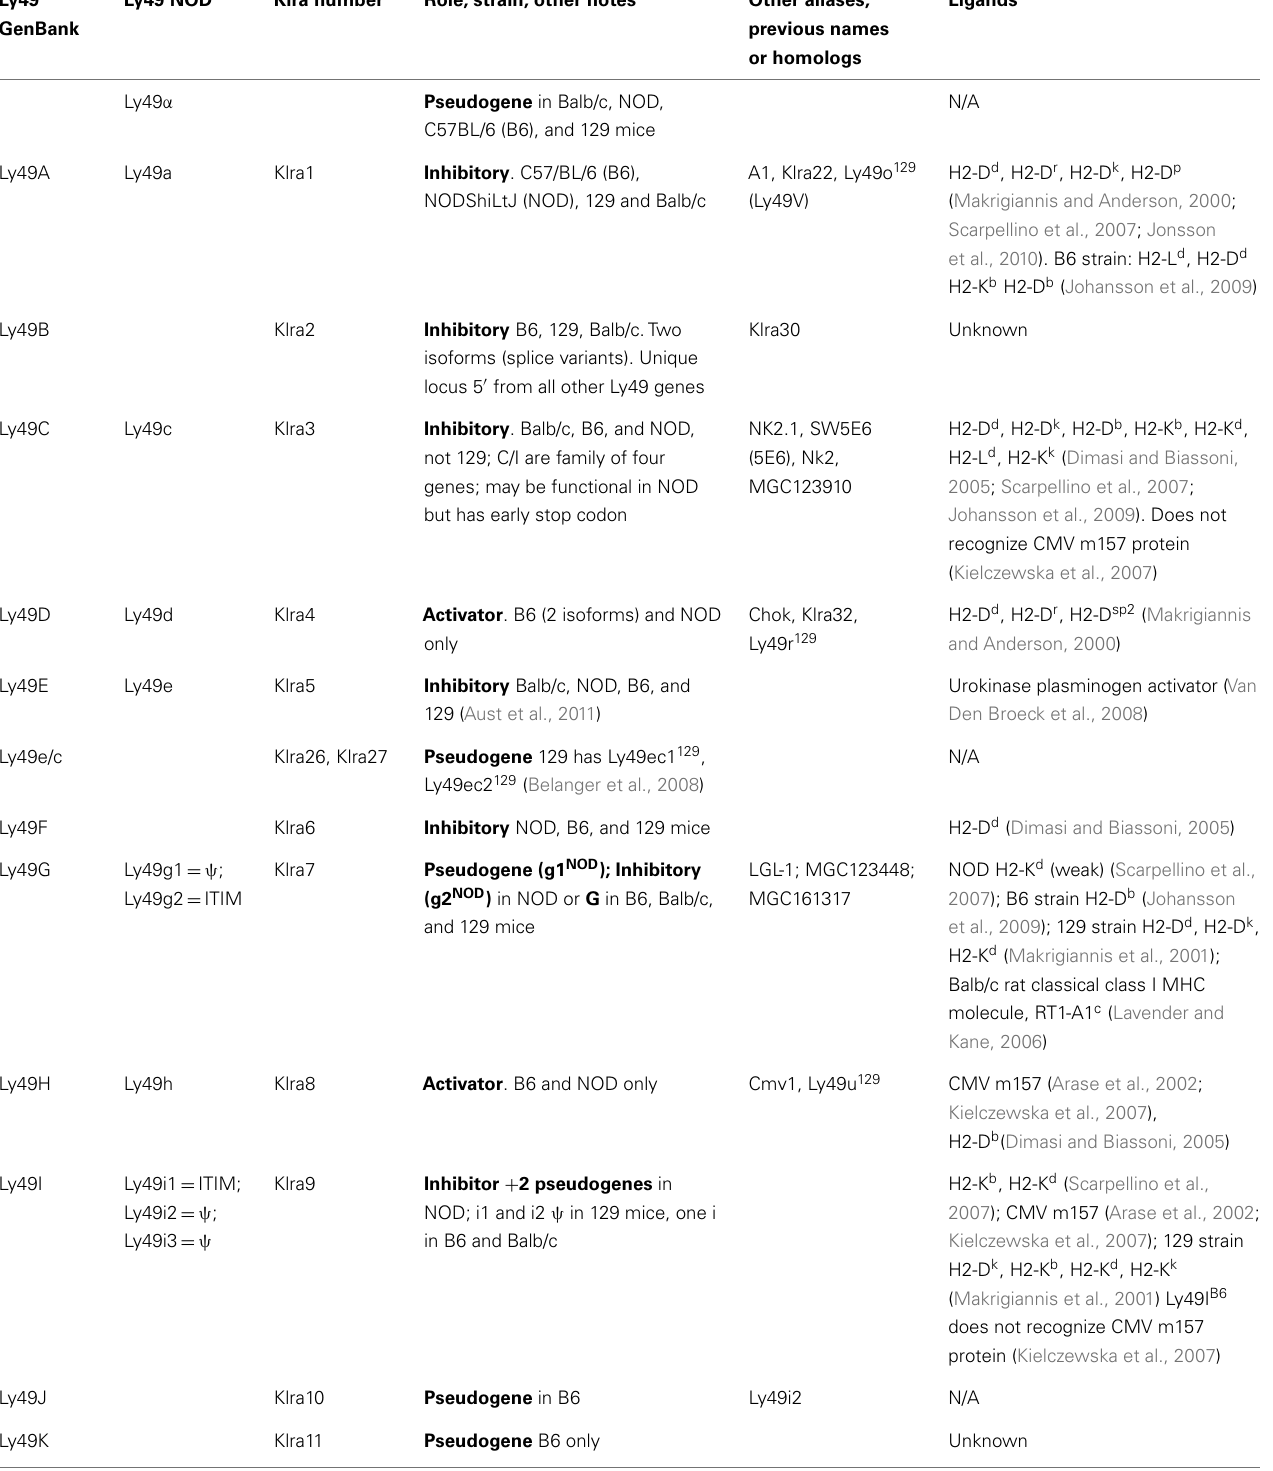
Table 1 | Combined nomenclature and ligands of the Ly49